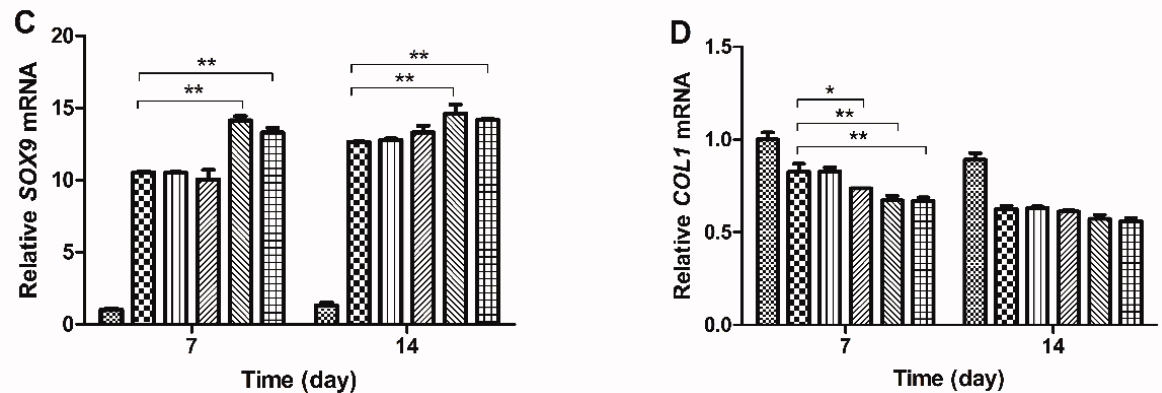
Figure 4. Relative gene expressions of MSCs on days 7 and 14. Groups 1 BT, 10 BT, 50 BT and 100 BT were designed to clarify the effect of BMP3/TGF- β on the expression of functional gene markers. Expression of ( A ) ACAN ; ( B ) COL2A1 ; ( C ) SOX9 and ( D ) COL1A1 was normalized to 18S and to the day 7 control group. C = control; T = 10 ng/mL TGF- β ; 1 BT = 1 ng/mL BMP3/10 ng/mL TGF- β ; 10 BT = 10 ng/mL BMP3/10 ng/mL TGF- β ; 50 BT = 50 ng/mL BMP3/10 ng/mL TGF- β ; 100 BT = 100 ng/mL BMP3/10 ng/mL TGF- β . Data represent mean ± SD; * p < 0.05, ** p <